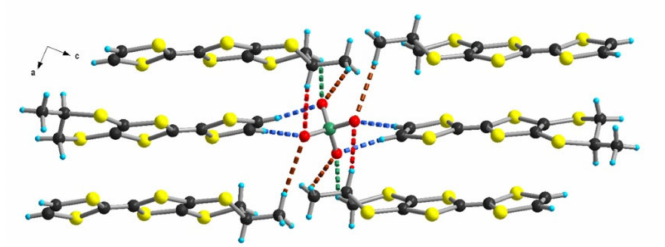
Figure 3. Solid-state structure of [( R )- 1 ] 2 ClO 4 , with an emphasis on the C–H ··· O short contacts: blue dotted lines for CH vinyl (2.43–2.51 Å), green dotted lines for CH 2 (2.46–2.63 Å), brown dotted lines for Me (2.62 Å) and red dotted line for CH Me (2.99